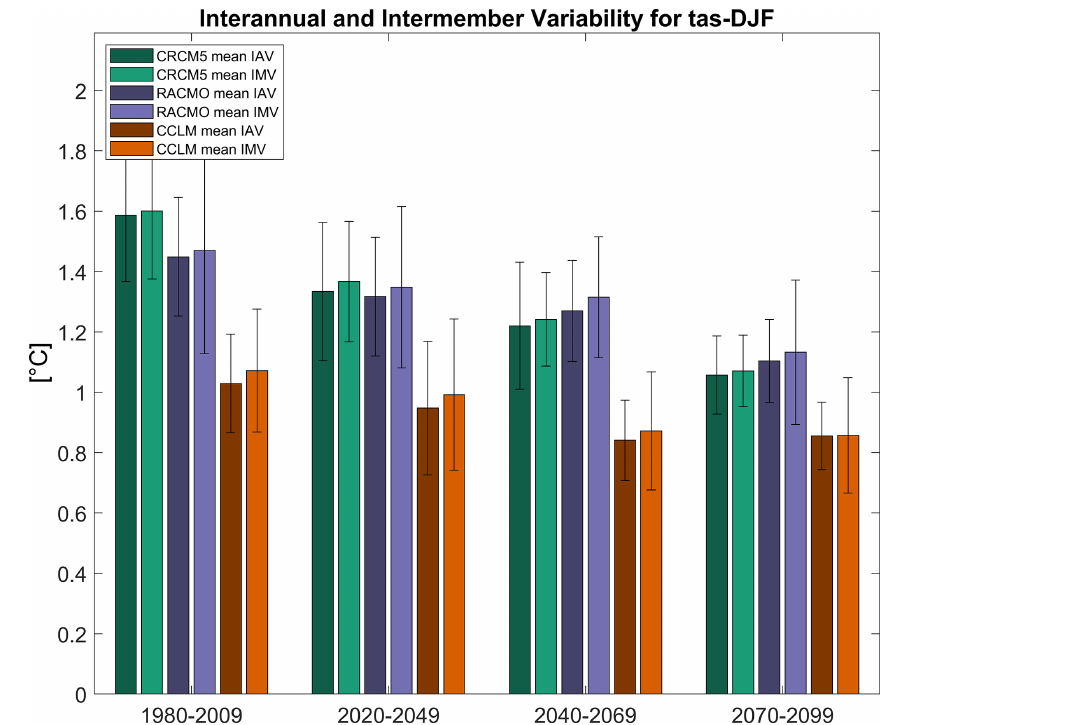
Figure 7. IAV and IMV of winter temperature in the three ensembles for the reference period (1980–2009) and three future periods. Bars: mean over the variability of each member (IAV) or year (IMV). Error bars: ± standard deviation (members or years); IMV: 16/21/50 mem- bers; IAV: 30 years of the respective